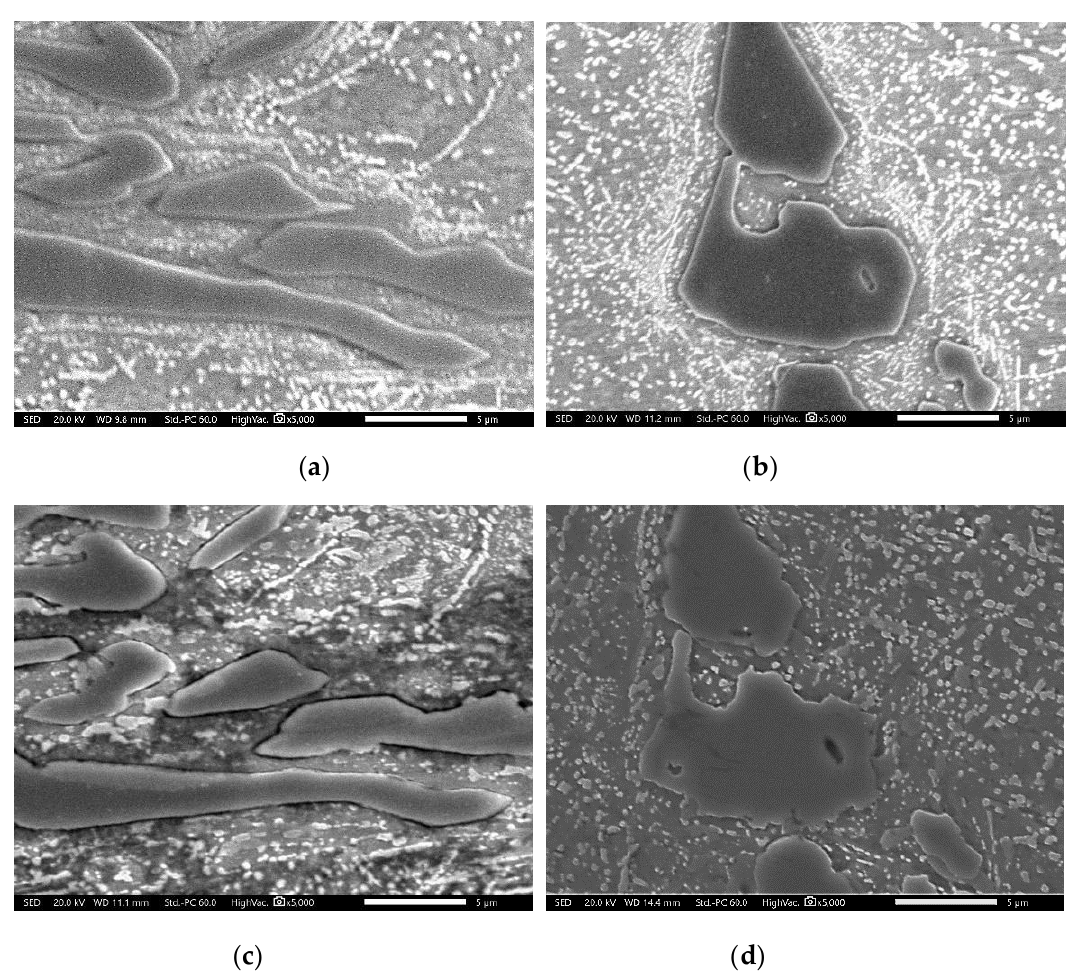
Figure 18. Microstructural evolution with exposure at each DA temperature under vacuum showing M 7 C 3 became smaller, and the interface became wavy as time elapsed: ( a ) 2124 DA at 850 °C for 240 min; ( b ) 2127 DA at 890 °C for 240 min; ( c ) (a) + 60 min under vacuum; ( d ) (b) + 60 min under vacuum.